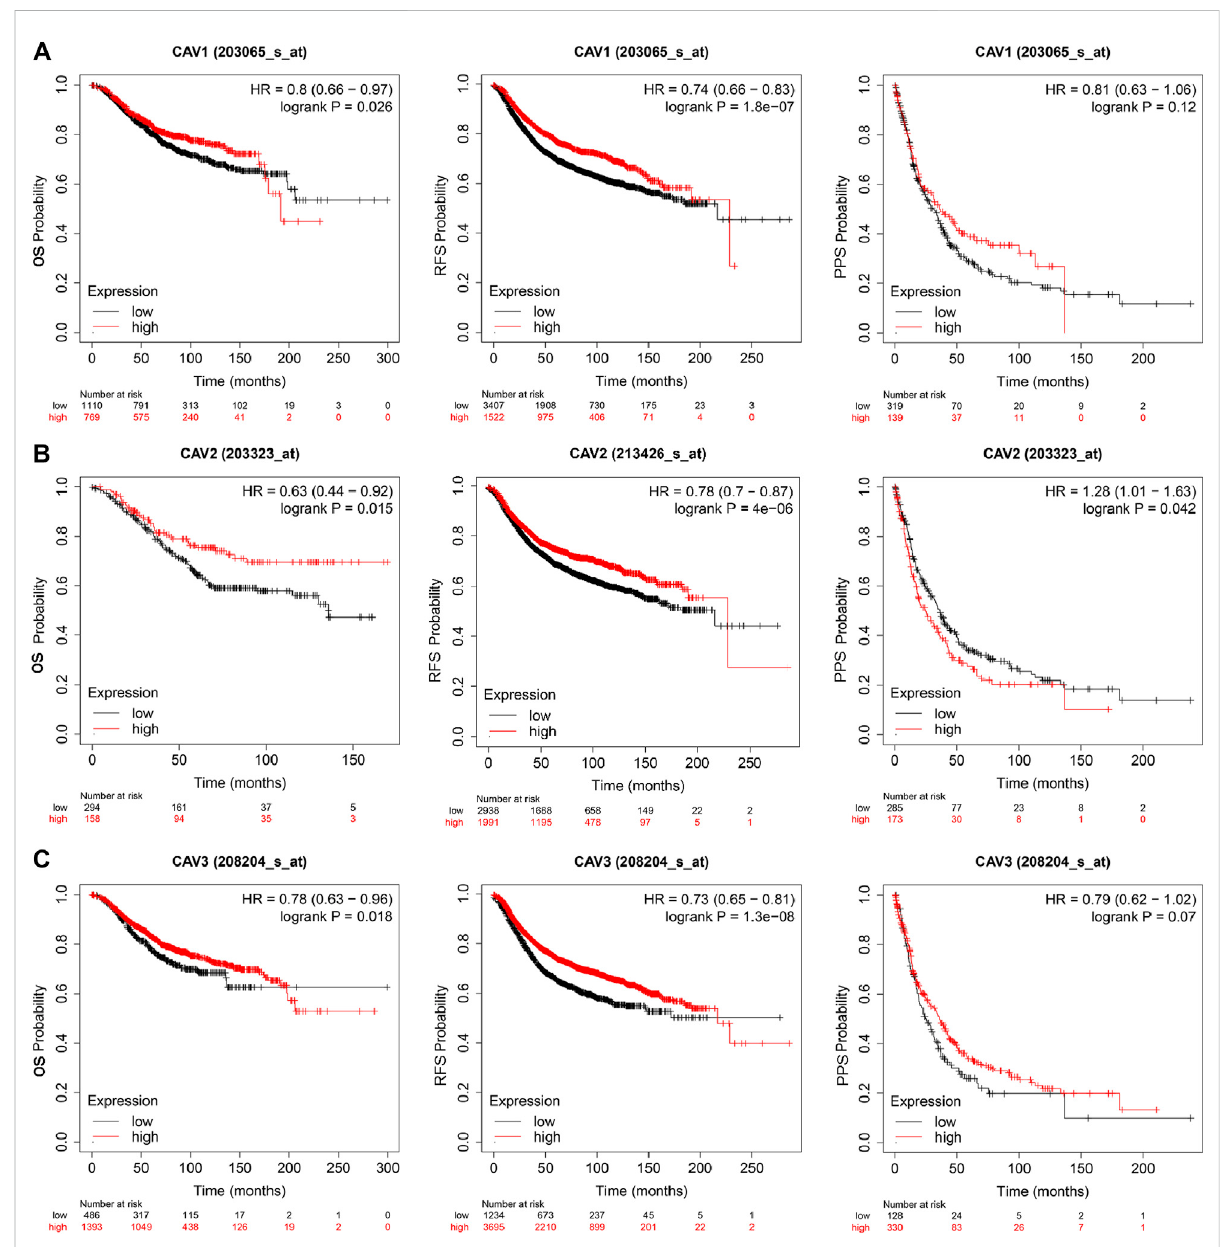
FIGURE 3 Kaplan – Meier survival curve analysis ( OS, RFS, PPS) for CAVs in BC (Kaplan – Meier plotter, https://kmplot.com/analysis/): (A) CAV1, (B) CAV2, and (C) CAV3.